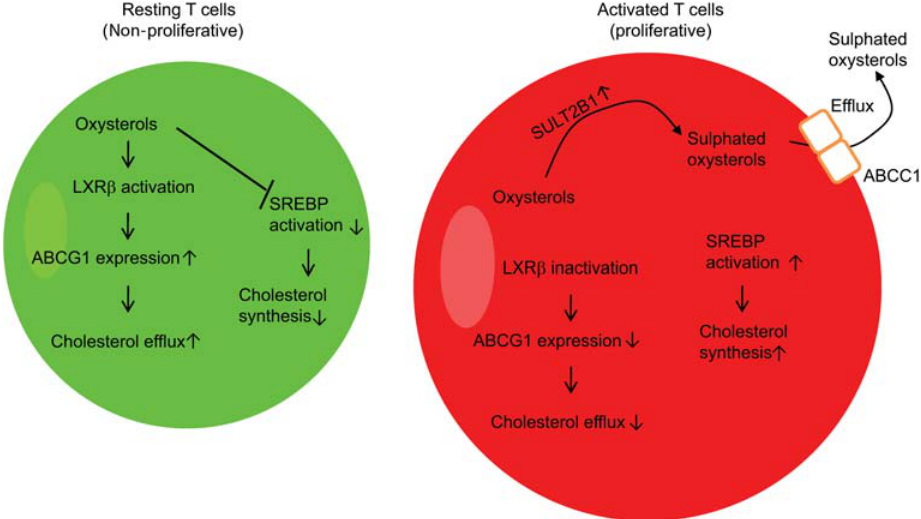
Figure 2 LXR signaling couples sterol homeostasis to T cell proliferation. In resting T cells, oxysterols suppress intracellular cholesterol levels by activating LXR b -dependent cholesterol efflux and inhibiting SREBP- dependent cholesterol synthesis. Upon antigen stimulation, expression of SULT2B1, which can inactivate oxysterols, is upregulated. Inac- tivation of SULT2B1-sensitive oxysterols results in downregulation of cholesterol efflux and upregulation of cholesterol synthesis. ABCG-deficient T cells are unable to proliferate in response to